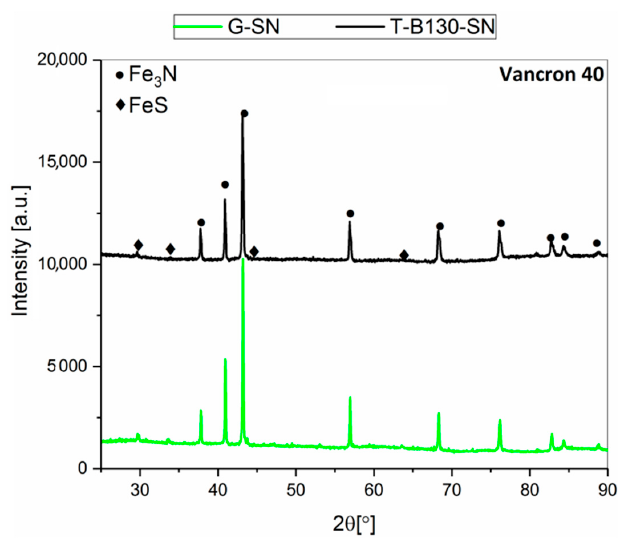
Figure 6. X-ray diffraction spectra recorded in the SL of Vancron 40 tool steel after: G-SN and T-B130-SN.